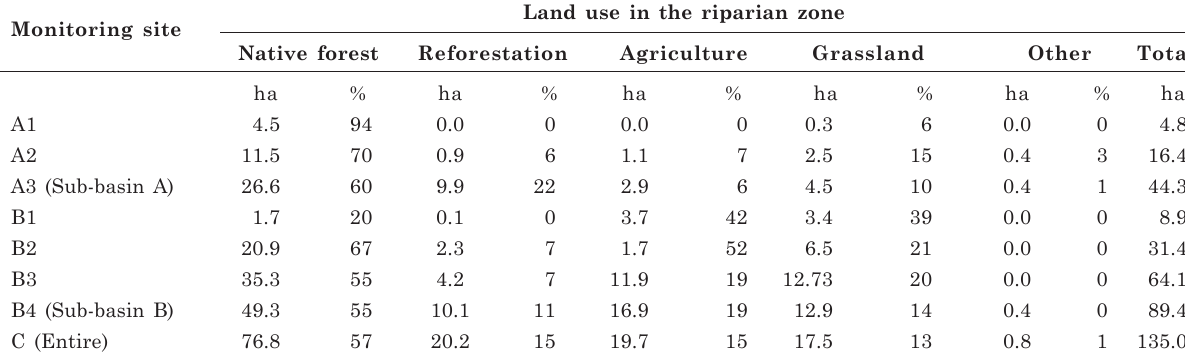
Table 3. Land use in the riparian zone (30 m each side of the river) in the Campestre Monitoring site